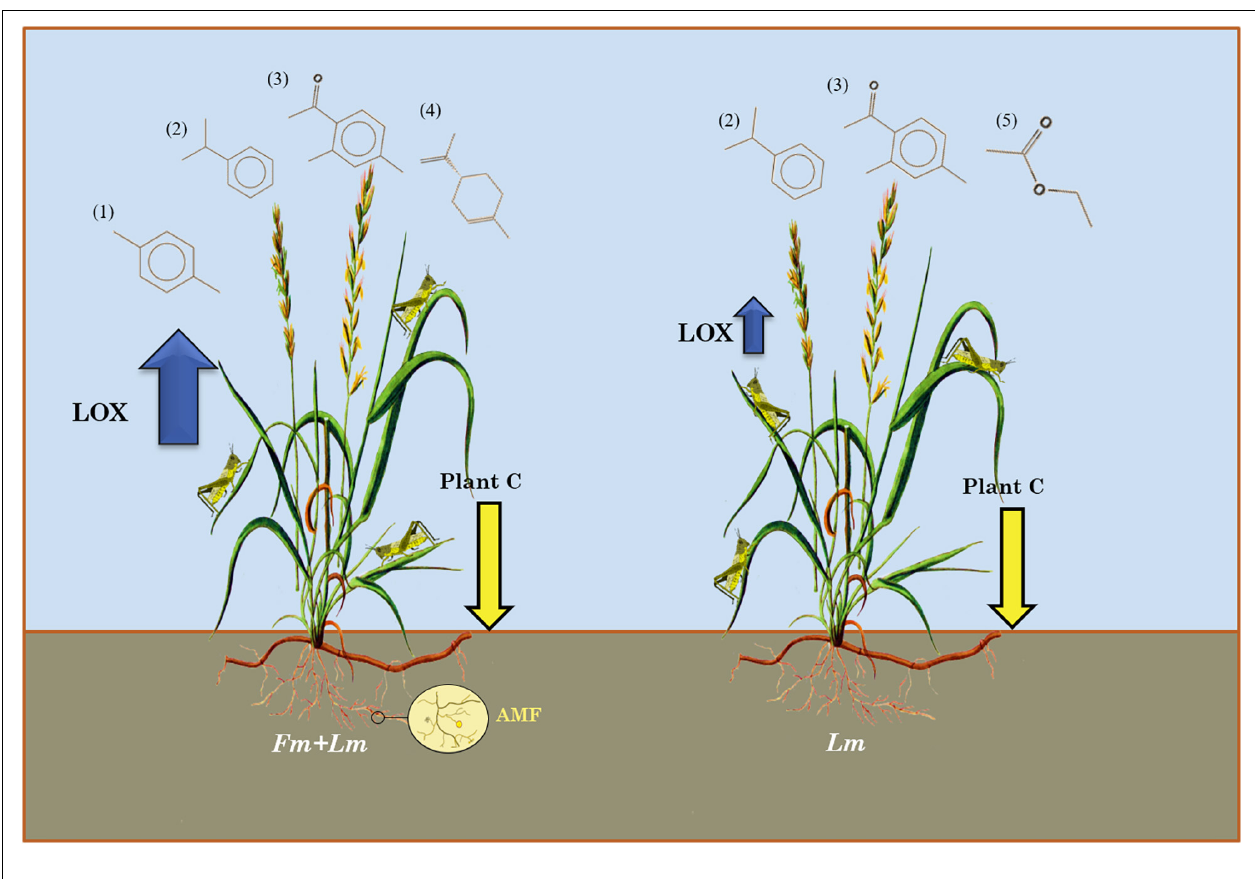
FIGURE 4 | Diagrammatic representation of the various means of E. nutans defense response induction by AMF. (1) p-Xylene, (2) Cumene, (3) 2,4-dimethylacetophenone, (4) D-Limonene, and (5) ethyl acetate.